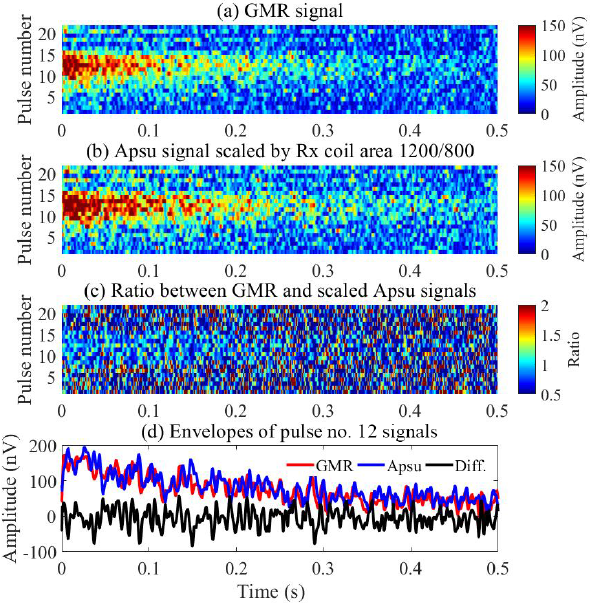
Figure 10. Data space comparison between the commercial GMR instrument and our Apsu receiver. (a) Data space of GMR results. (b) Data space of Apsu results after being scaled to the GMR signal by the area-turn factor of 1200 / 800. (c) Ratio of the GMR and the Apsu signals. (d) Envelopes of the pulse no. 12 NMR signal from the two instruments and the